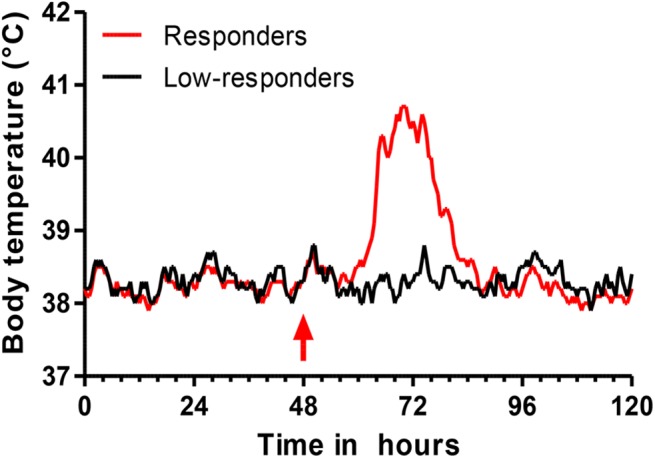
Monitoring of the bodily temperature with an intravaginal sensor system.Median values of body temperature of high responder and low-responder cows before and after the intramammary challenge with OVA at 48 h (red arrow). Minor ticks indicate 4-hour intervals.